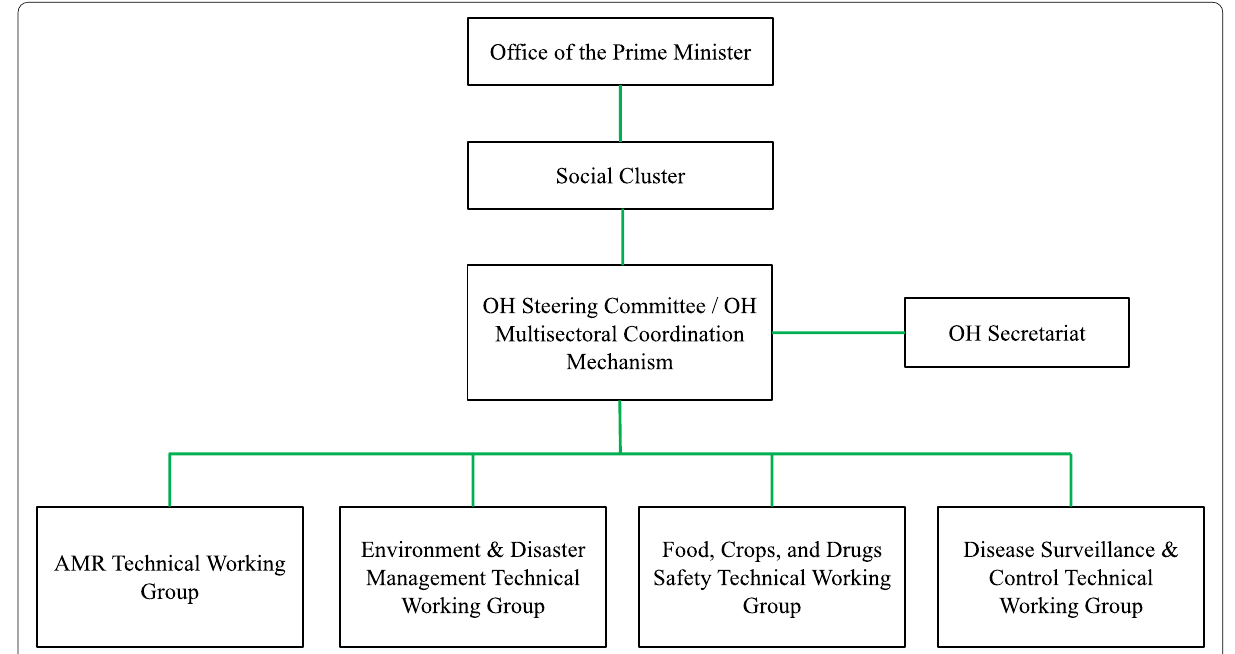
Fig. 3 Rwanda’s OH governance framework adapted from the One Health Policy